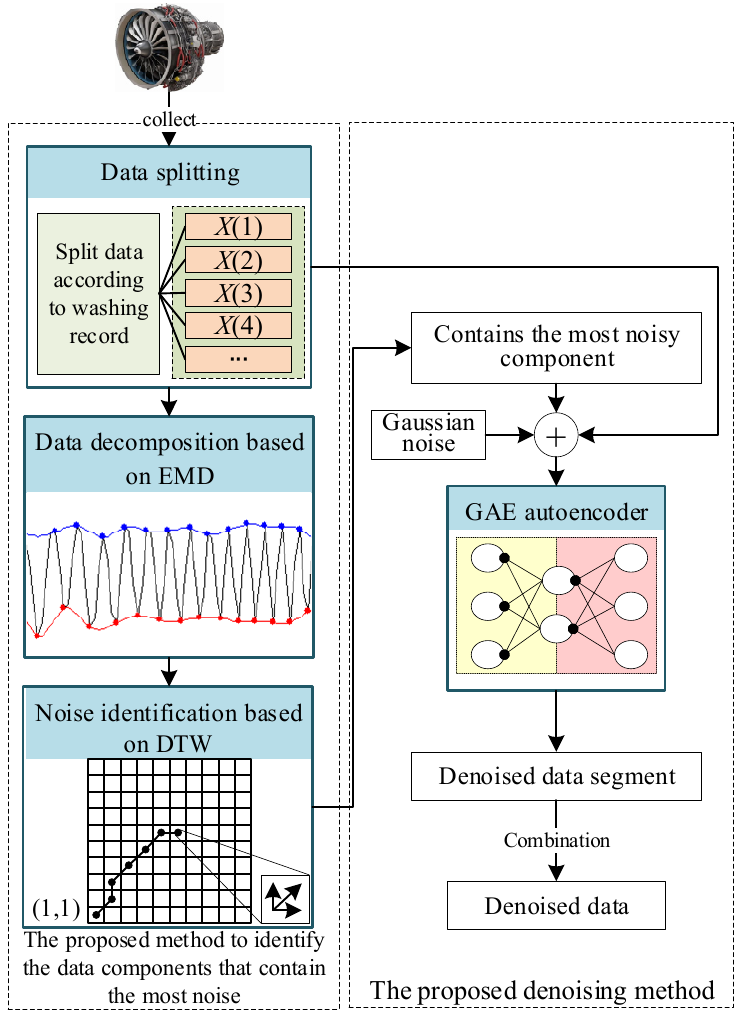
Figure 3. Denoising method for aeroengine data based on a hybrid